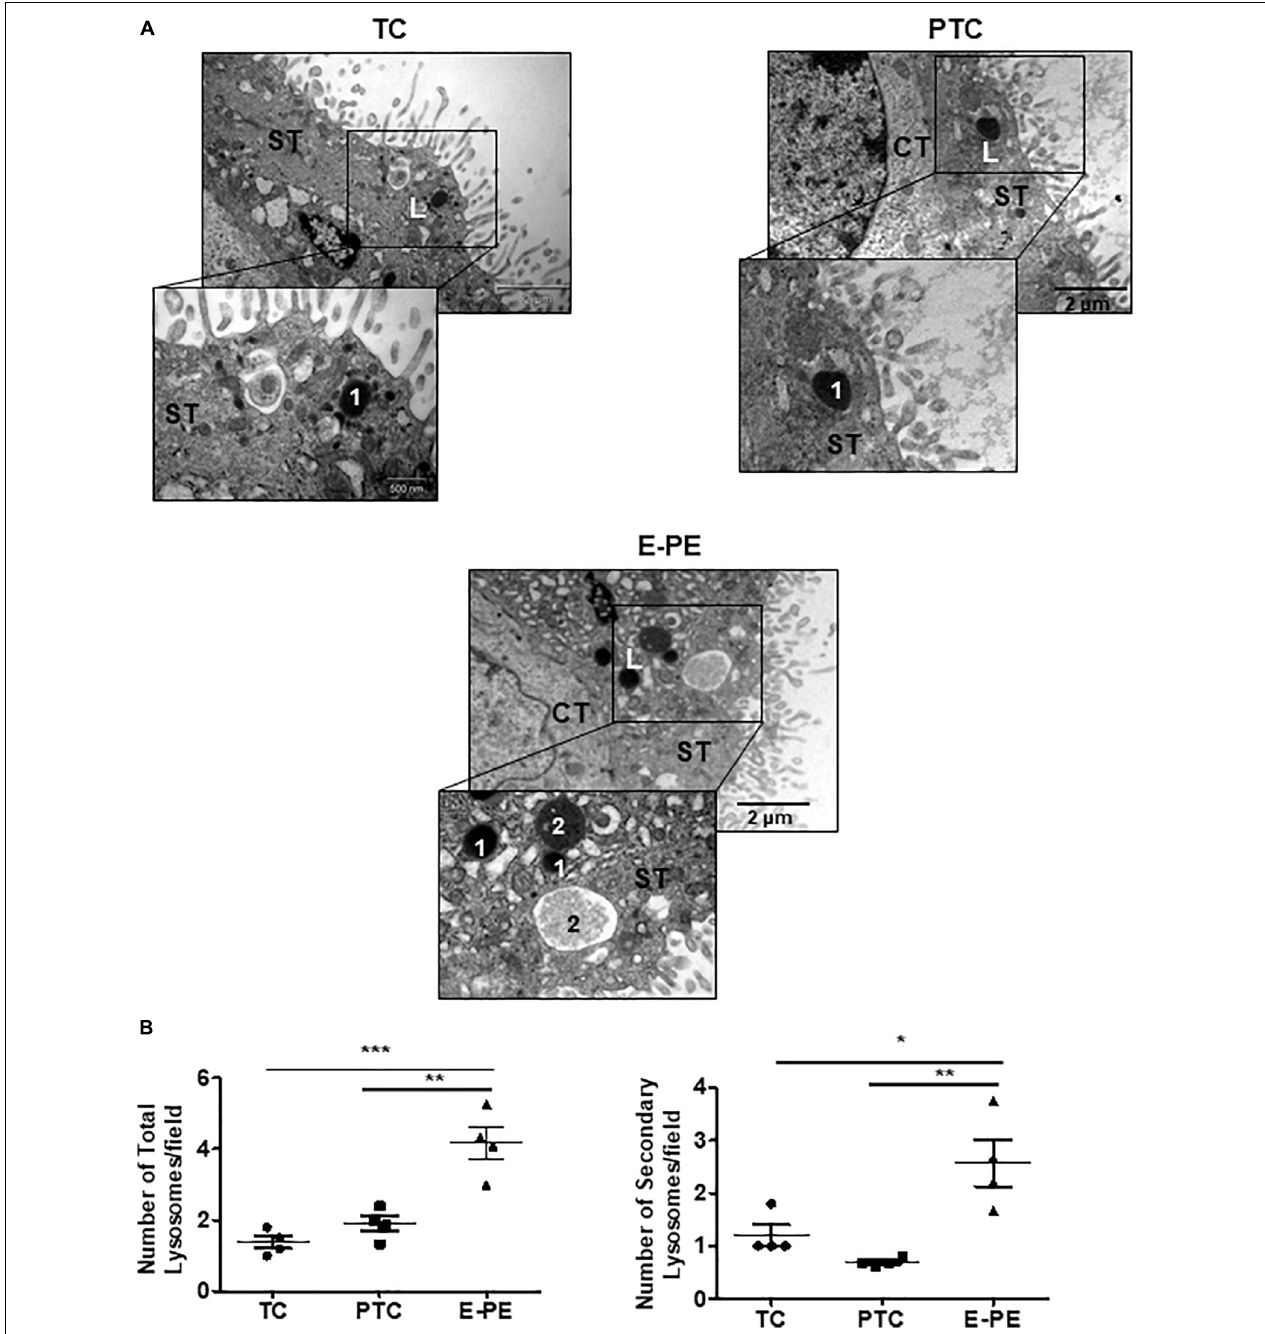
FIGURE 1 | Lysosome morphology in E-PE and control placentae. (A) Representative TEM images of syncytiotrophoblast cells from TC, PTC and PE placental sections. L, lysosomes; 1 primary lysosome; 2 secondary lysosome. CT, cytotrophoblast; ST, syncytiotrophoblast. (B) Number of total and secondary lysosomes in syncytiotrophoblast cells from PCT and PE placentae (PE, N = 4; PTC, N = 4; ** P < 0.01 compared to